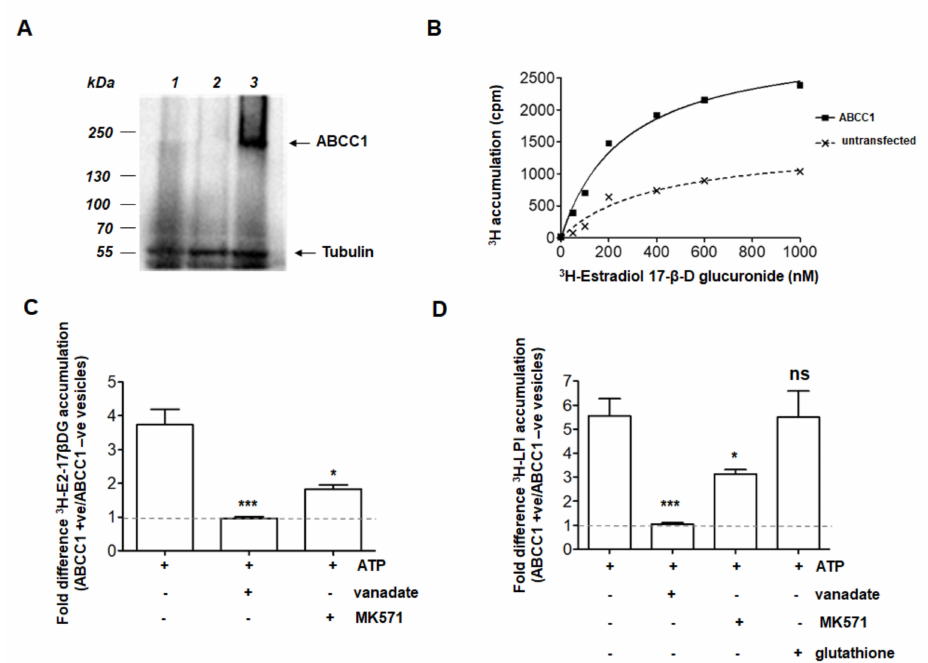
Figure 2. LPI is a transport substrate of ABCC1. ( A ) Expression of ABCC1 in HEK293T cells. Western blot probed with anti-ABCC1 antibody and anti-tubulin as loading control. Lane 1, whole cell lysate prepared from untransfected HEK293T; lane 2, whole cell lysate prepared from